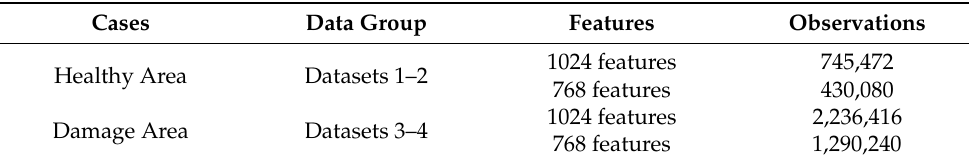
Table 11. Data features and number of observations.